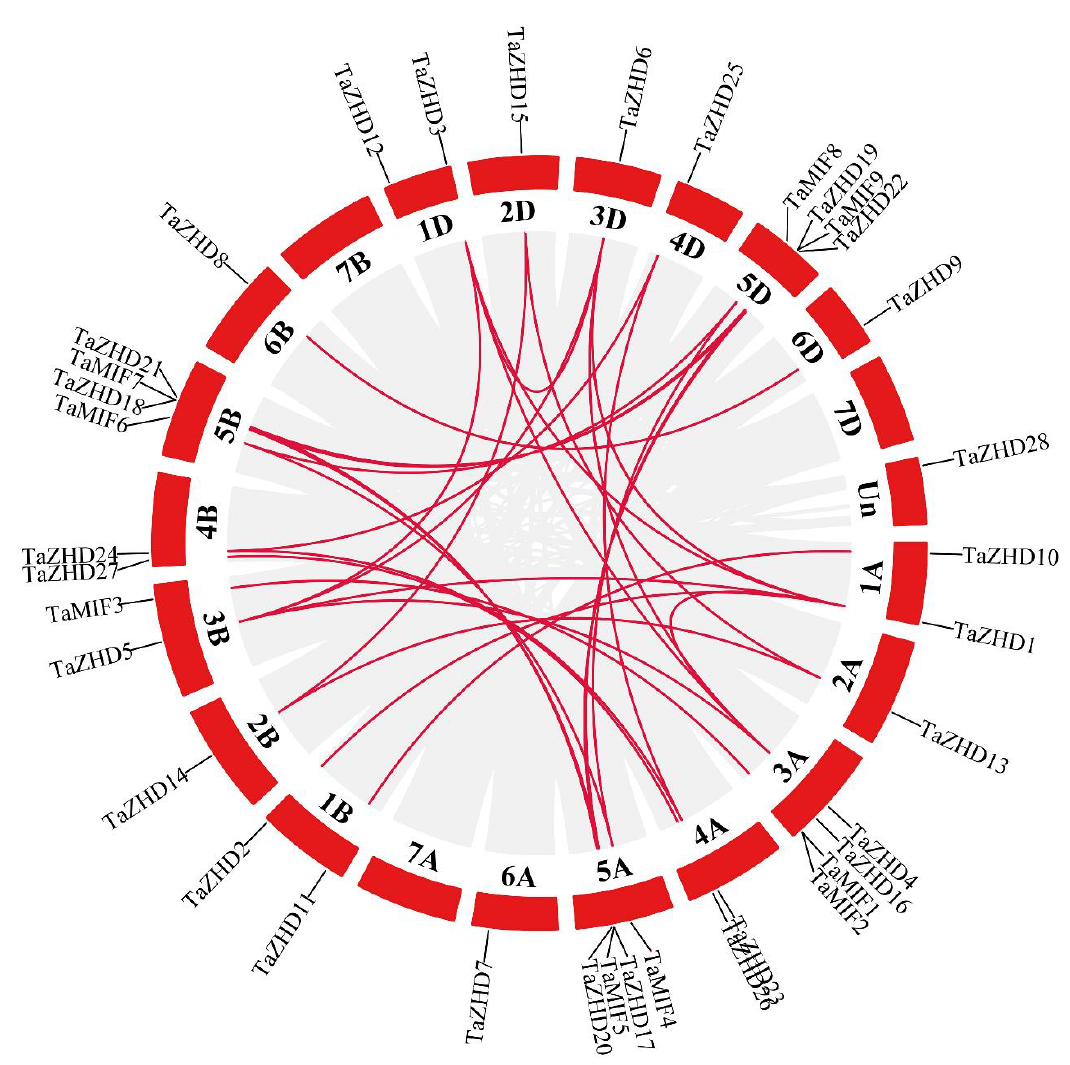
Figure 4. Chromosomal localizations and syntenic relationships among TaZF-HD genes in T. aestivum . Gray lines in the background indicate the collinear blocks among T. aestivum and red lines highlight the syntenic TaZF-HD gene pairs.